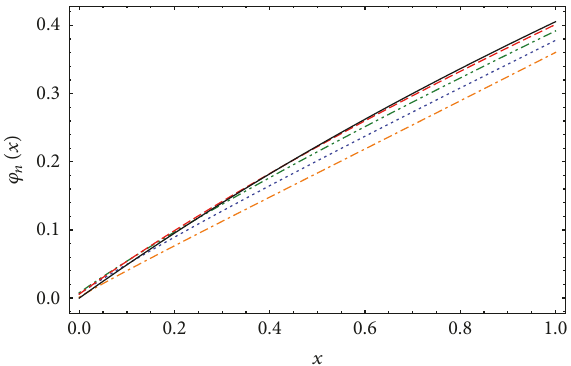
Figure 6: 𝜑 𝑛 (𝑥) when 𝑛 = 15 obtained by the Duan-Rach modified ADM for 𝛼 = 1.2 (dot-dash), 𝛼 = 1.4 (dot line), 𝛼 = 1.6 (dot-dot- dash), 𝛼 = 1.8 (dash line), and 𝛼 = 2 (solid line).